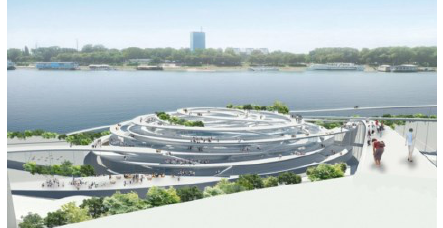
Figure 8. Revitalization of Port "BetonHala"/ Sou Fujimoto (https://www.archdaily.com/286381/beton-hala-waterfront-